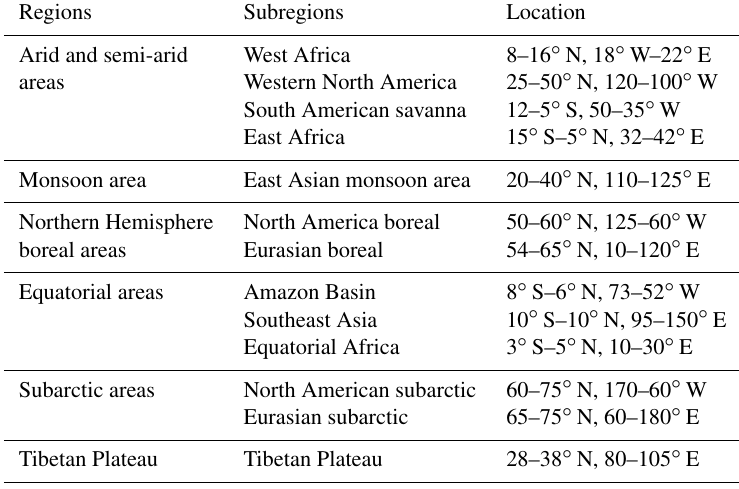
Table 3. Statistics for the comparison between SSiB4/TRIFFID simulated and observation-based LAI and GPP. Regions